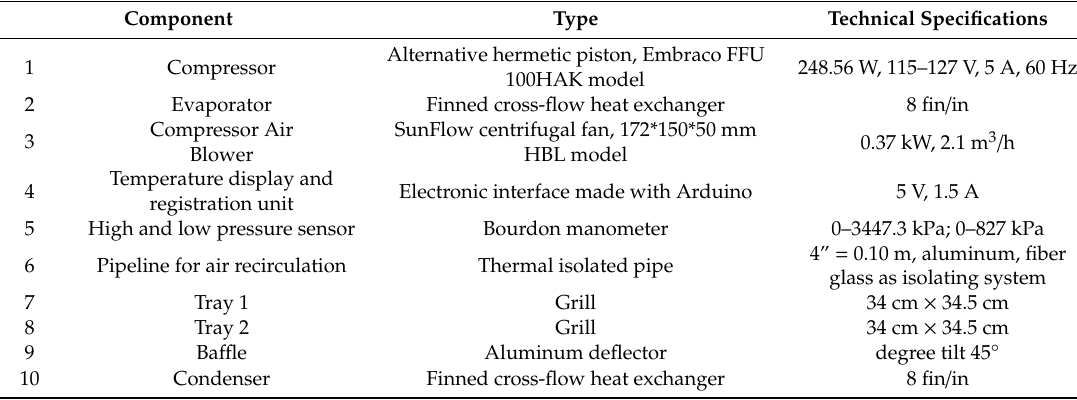
Figure 1. Experimental test bench for Oregano drying: ( a ) Schematic diagram of HPDS test bench used for the experimental analysis; ( b ) Experimental arrangement for Oregano drying. Table 1. Components and specifications of the HPD